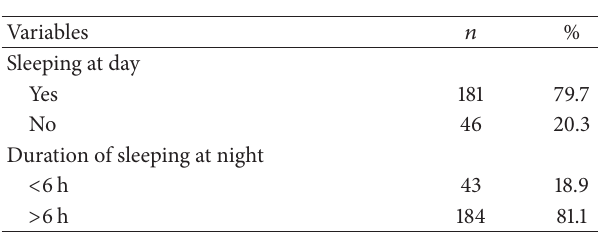
Table 1: Characteristic of the